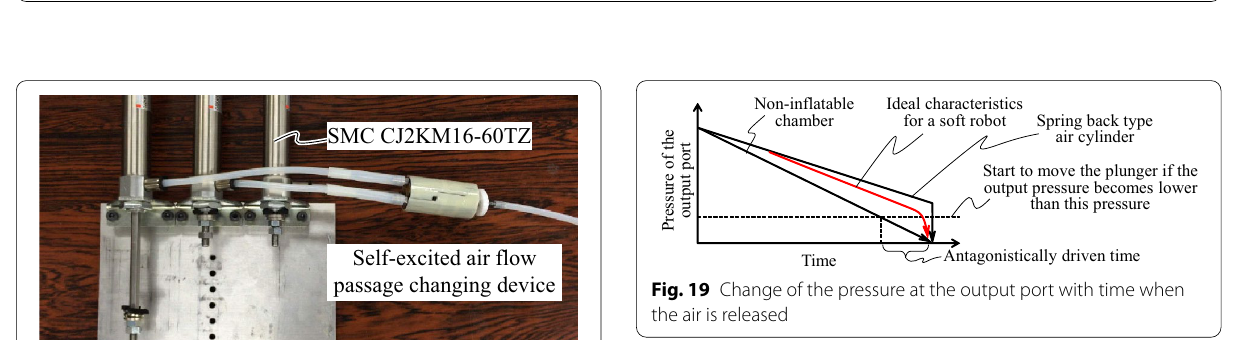
Fig. 17 Experiment to drive the device in a 25A pipe